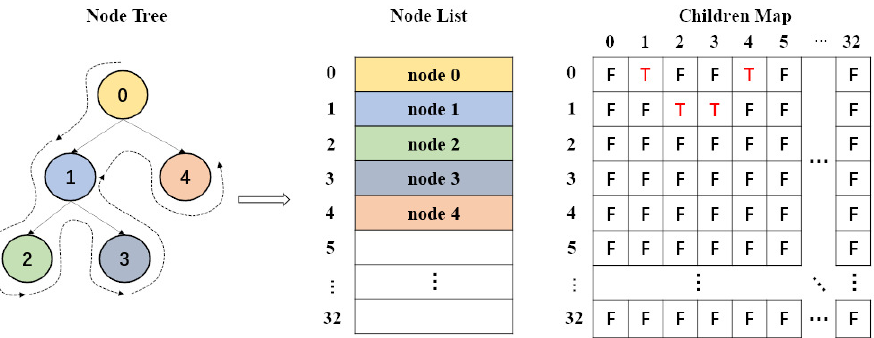
Figure 2. Transformation the original node tree structure into the node-list format. The heterogeneous node tree was reconstructed in its traversed order (depth-first) into the node list where an additional children map was built to reflect the relationship among the nodes. For example, the node 0 has two children-nodes (the node 1 and the node 4) and so the row 0 has two “T”s (indicating “True”) in the 1st and 4th